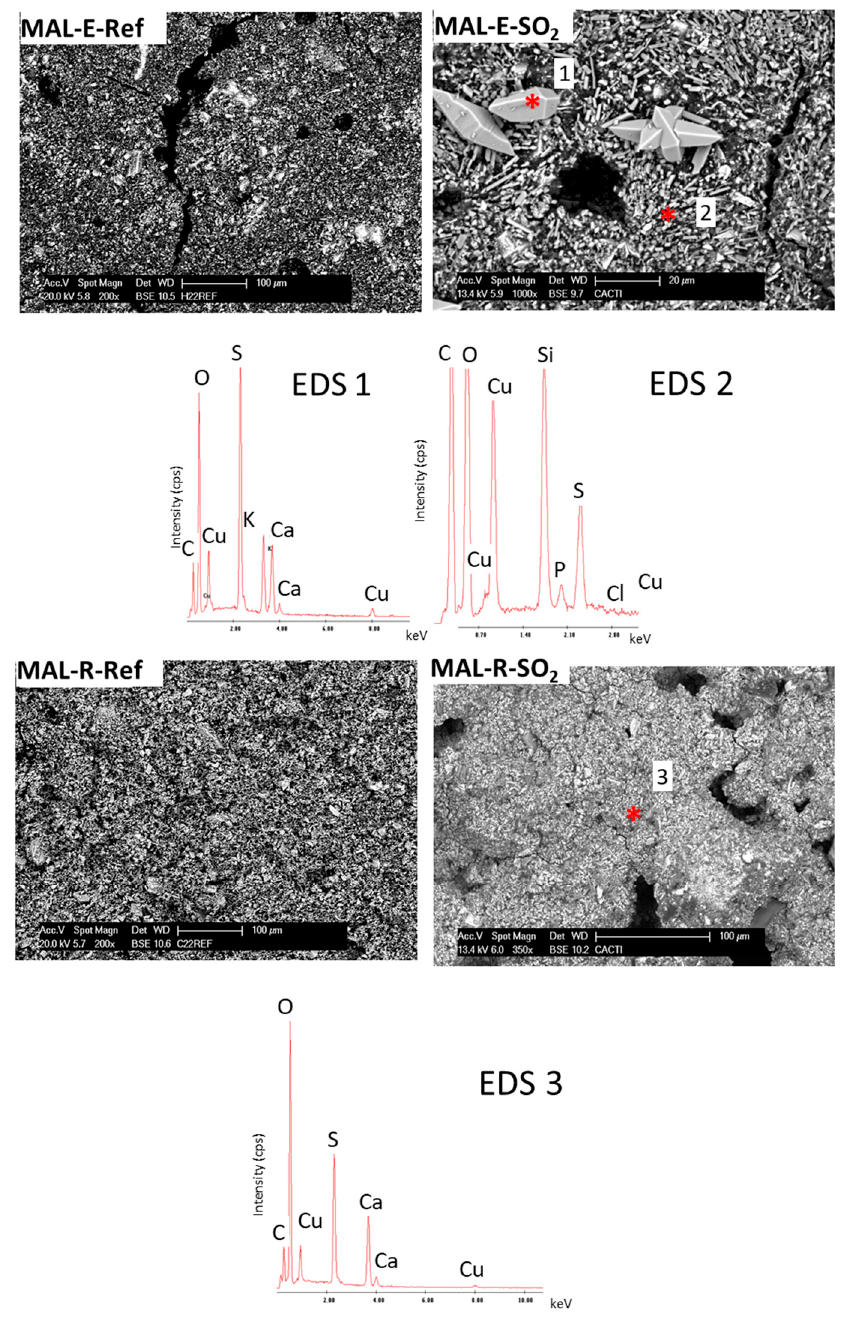
Figure 7. SEM micrographs of the reference (Ref) and aged (SO 2 ) paint mock-ups made with malachite (MAL) mixed with egg yolk (E) or rabbit glue (R). Some of the micrographs are accompanied by EDS spectra (depicted through the number EDS). See Table 1 for the labeling of paint mock-ups.